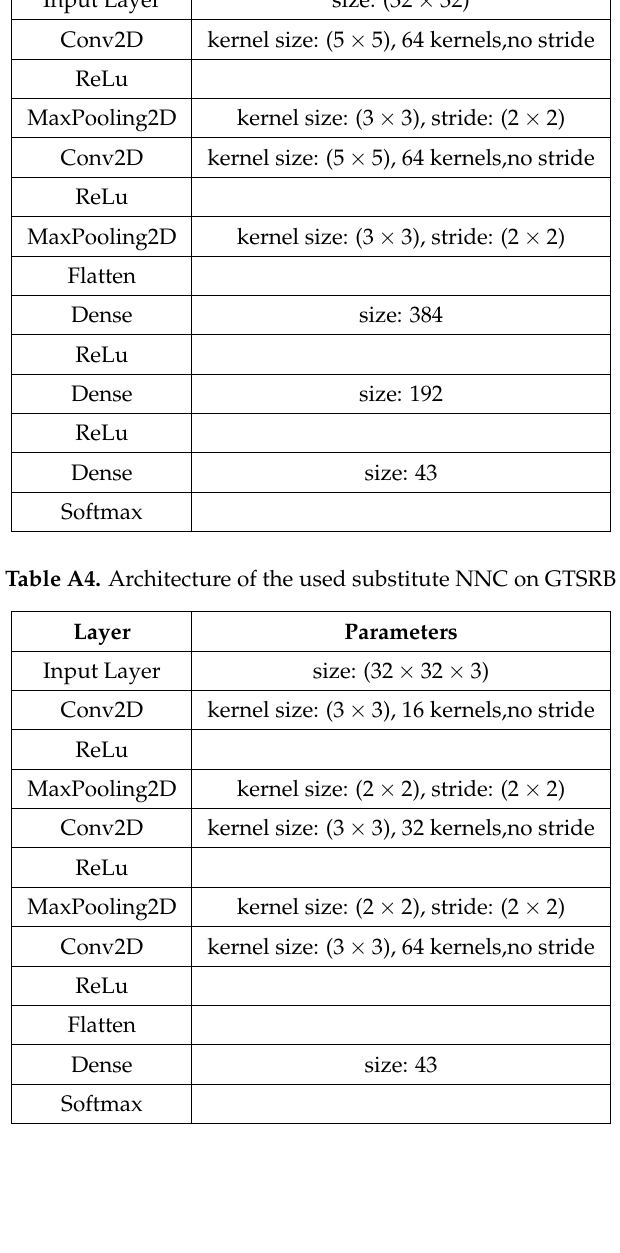
Table A3. Architecture of the used NNC on GTSRB (AlexNet inspired) Layer